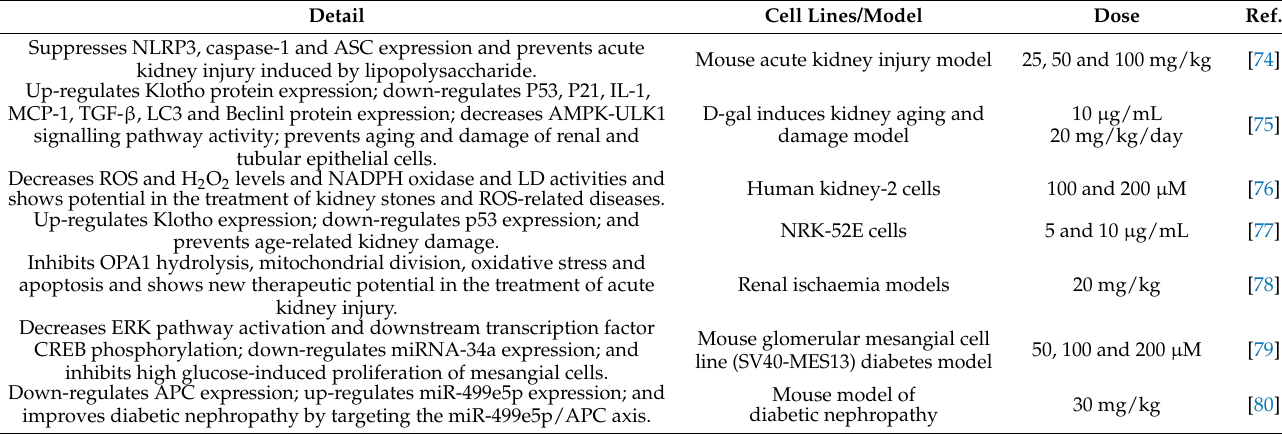
Table 6. Renal-Protective Activity of Hyperoside.